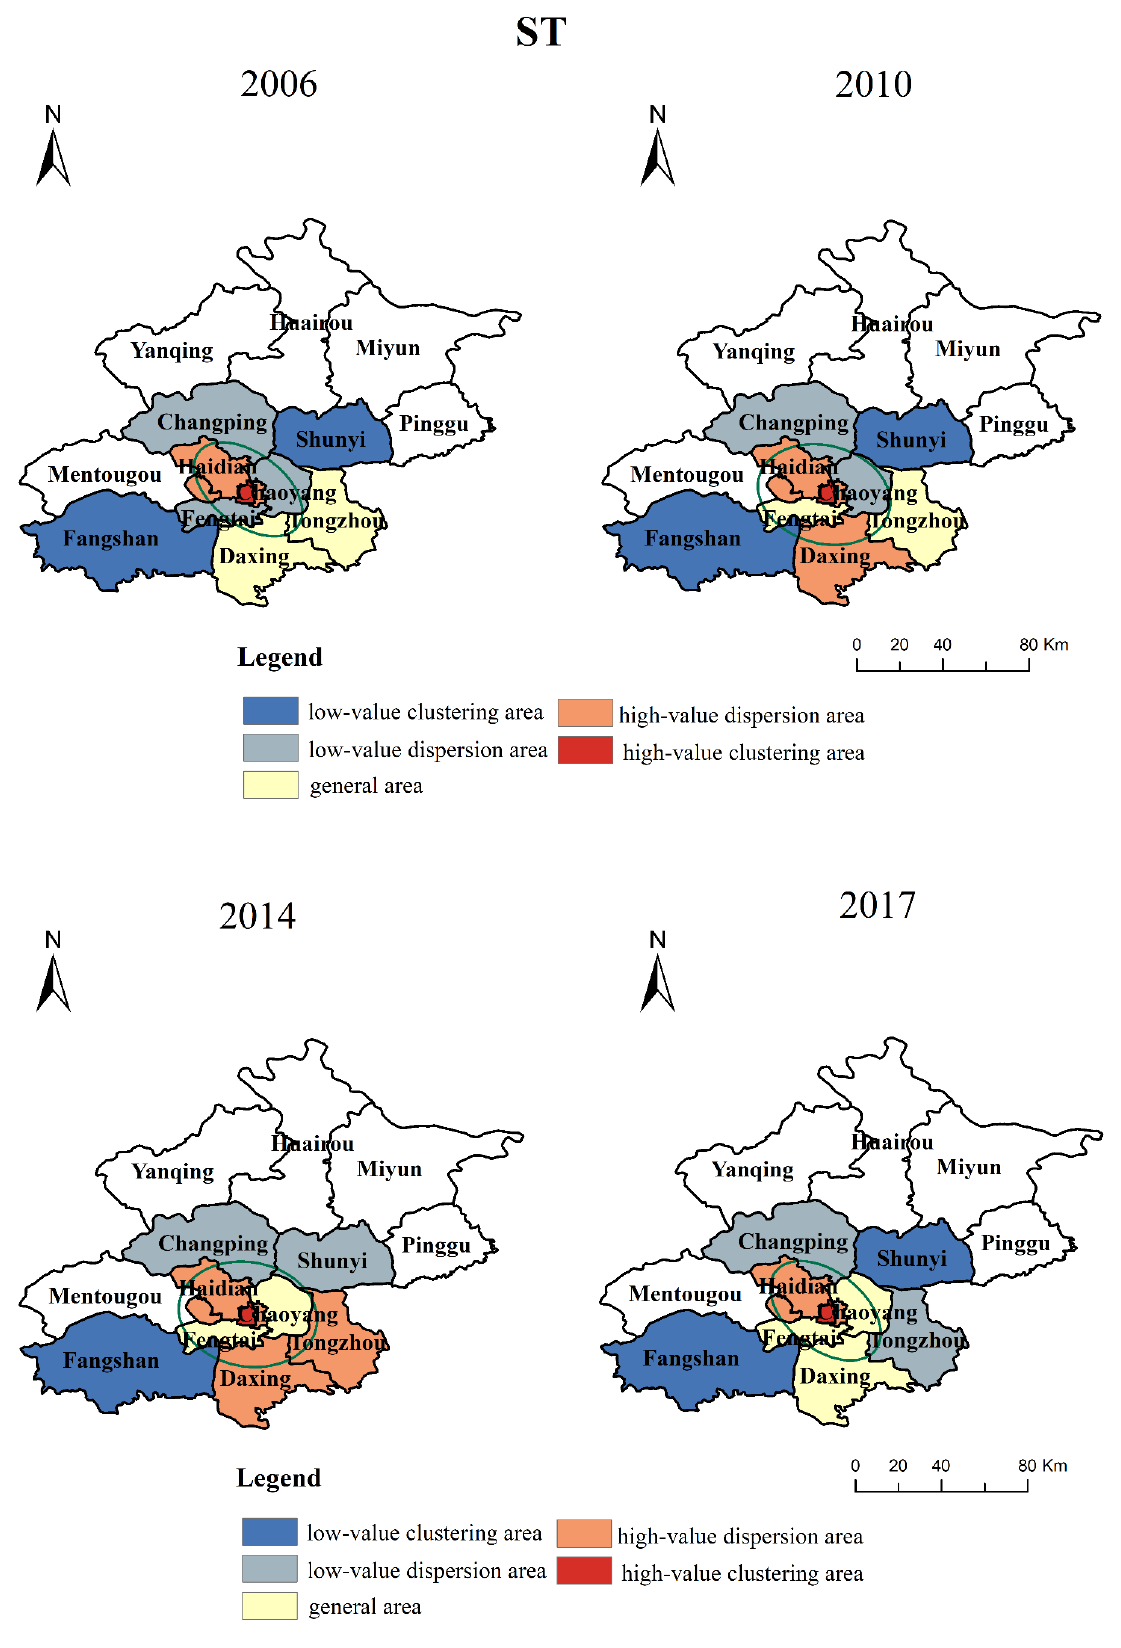
Figure 6. The spatiotemporal distribution of high–low value clustering points with different pairwise coupling coordination degrees.